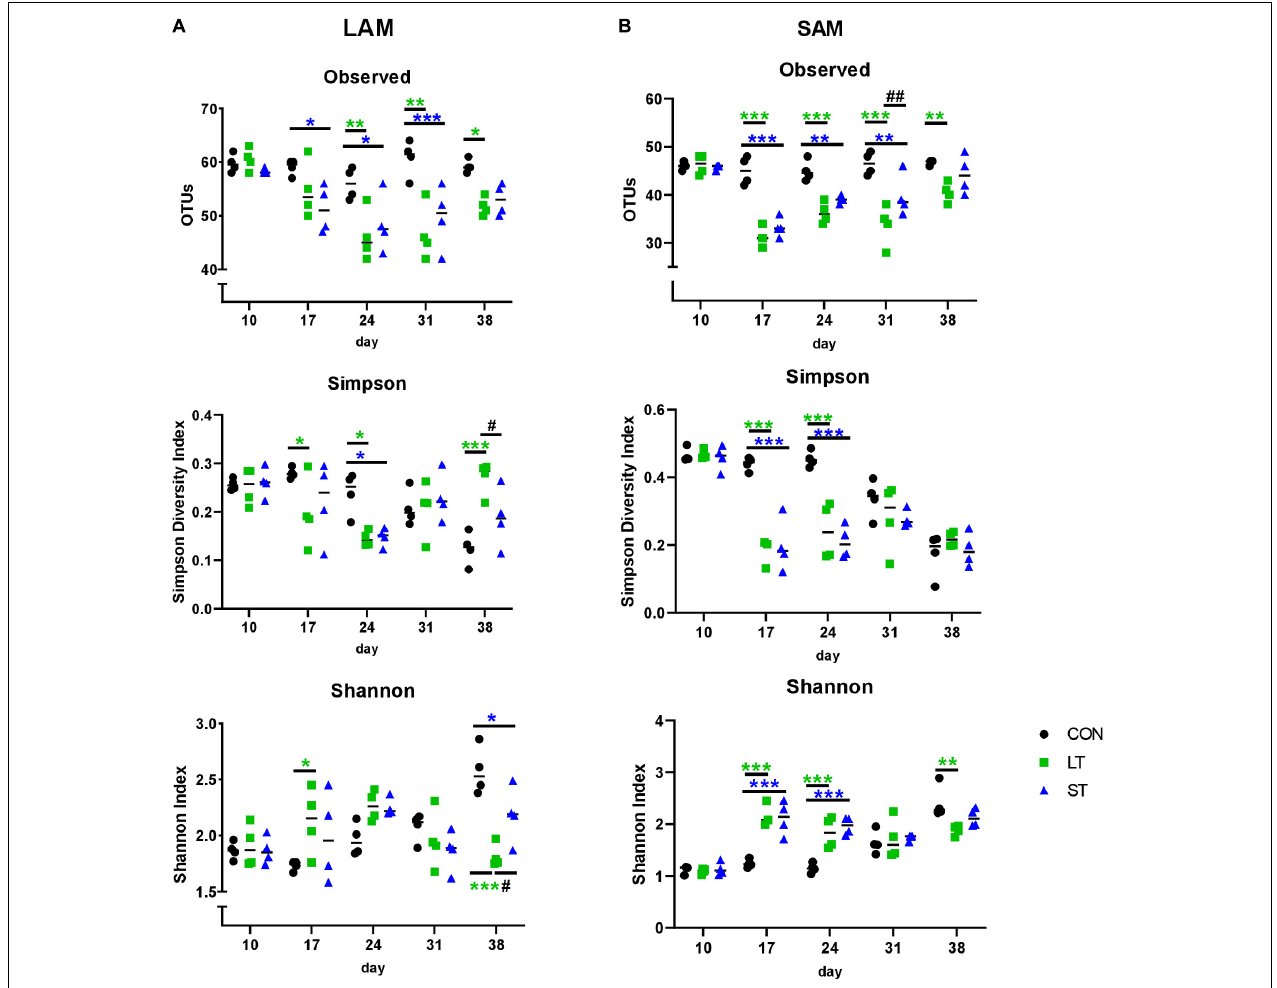
FIGURE 3 | Number of observed operational taxonomic units (OTUs), Simpson’s Diversity Index, and Shannon’s Index in LAM (A) and SAM (B) of Archaea by treatment groups ( n = 4). Individual data and medians are presented. ST, short-term group; LT, long-term group; CON, control group. The treatment effects of the Tukey post hoc test are indicated by * P < 0.05, ** P < 0.01, *** P < 0.001 (CON vs. LT or CON vs. ST); # P < 0.05, ## P < 0.01 (LT vs. ST). Time effects are not